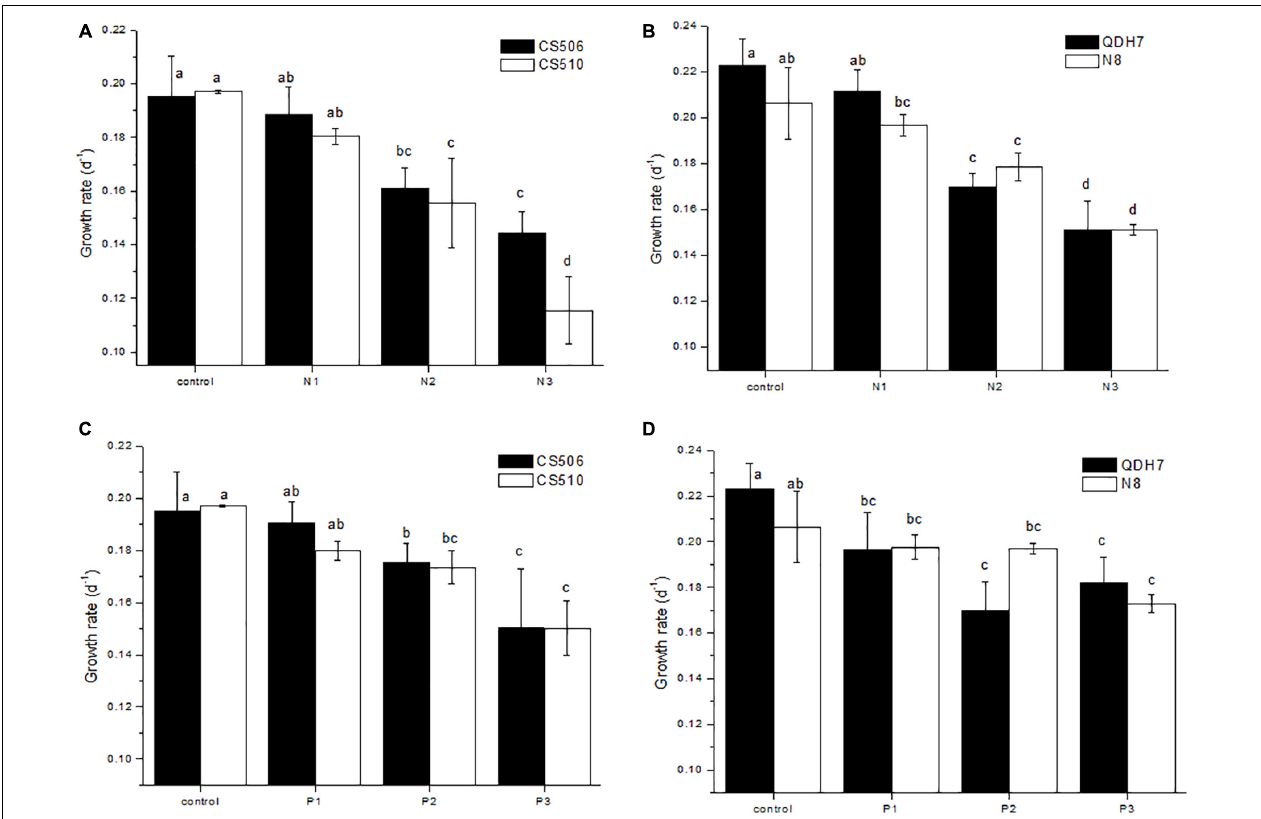
FIGURE 4 | Specific growth rates ( µ ) for two Australian (CS506 and CS510) and two Chinese (QDH7 and N8) strains of R. raciborskii under different nitrogen (A,B) or phosphorus (C,D) concentrations in the monoculture experiments. Growth rates were calculated with chl-a over days 1-7, and statistical difference between treatments within strains, and between strains, was denoted by letters above